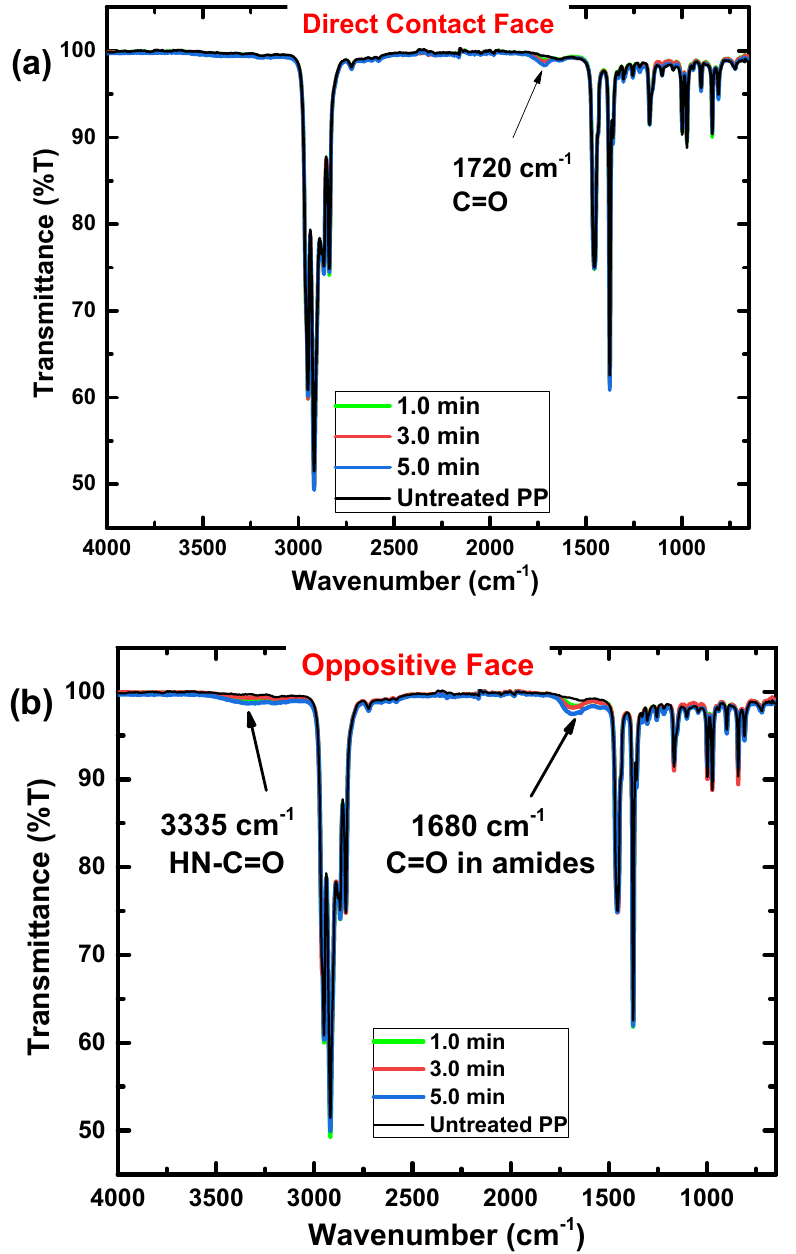
Figure 4. FTIR full spectra of polypropylene samples untreated, and treated by 1.0, 3.0, and 5.0 min. ( a ) DCF; and ( b ) OF.